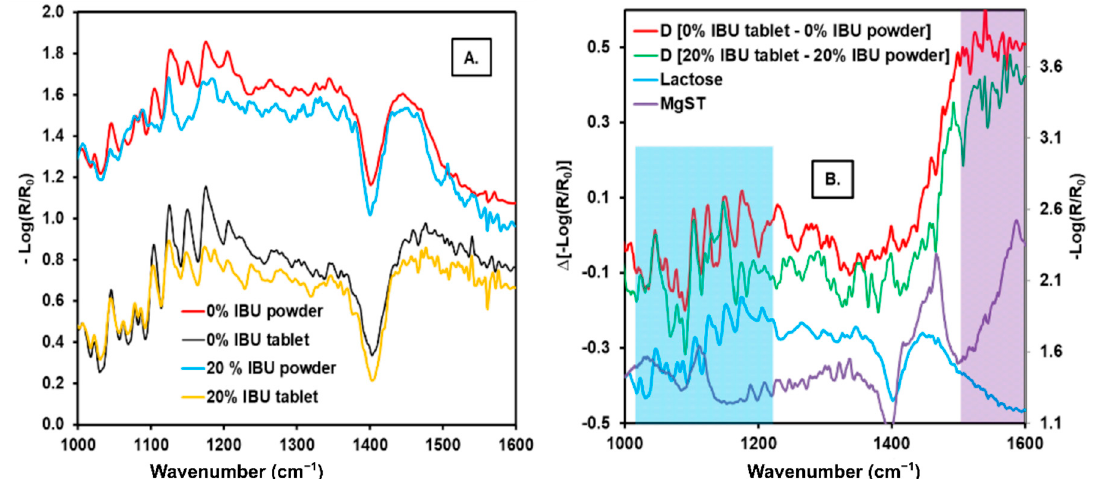
Figure 4. ( A ) Comparison of the QCL reflectance spectra of the tablets and powders with 0% and 20% API and ( B ) weighted spectral subtraction between the tablet spectrum and that of the powder with 0% and 20% API.